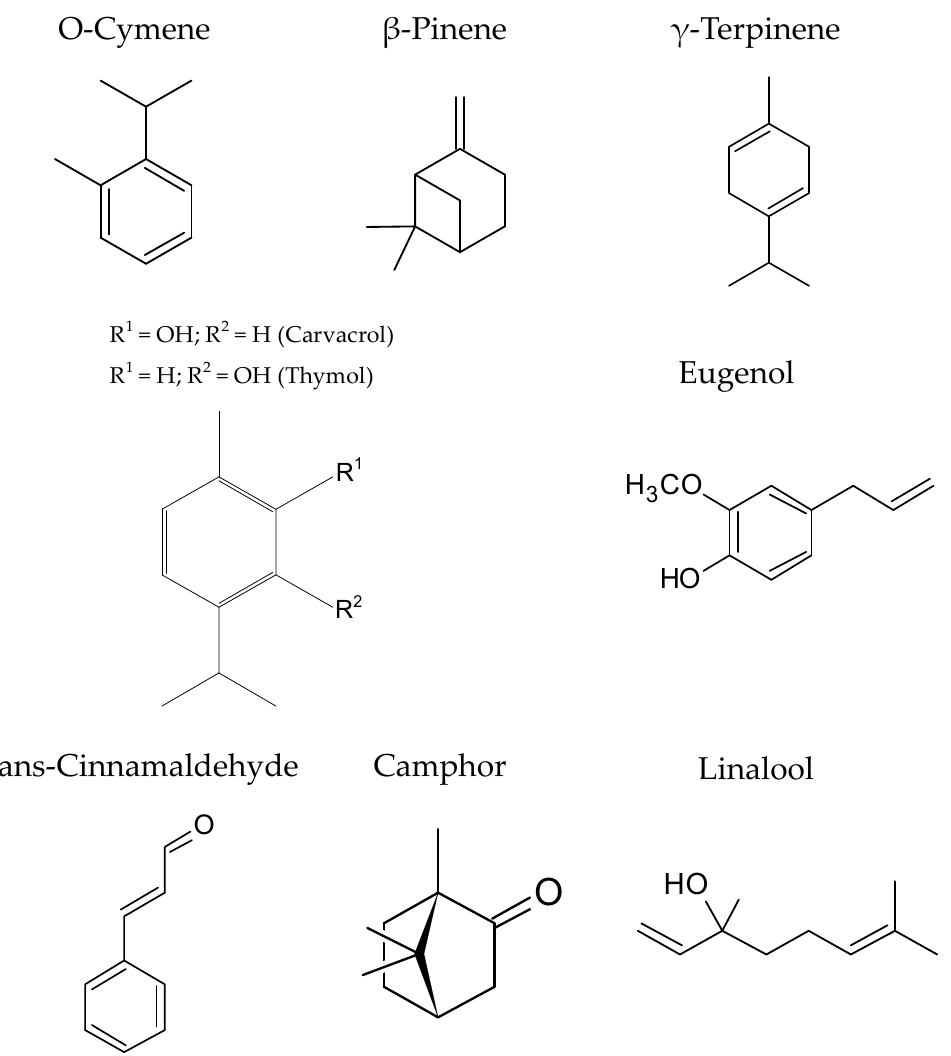
Figure 4. Chemical structures of the main bioactive compounds in essential oils.